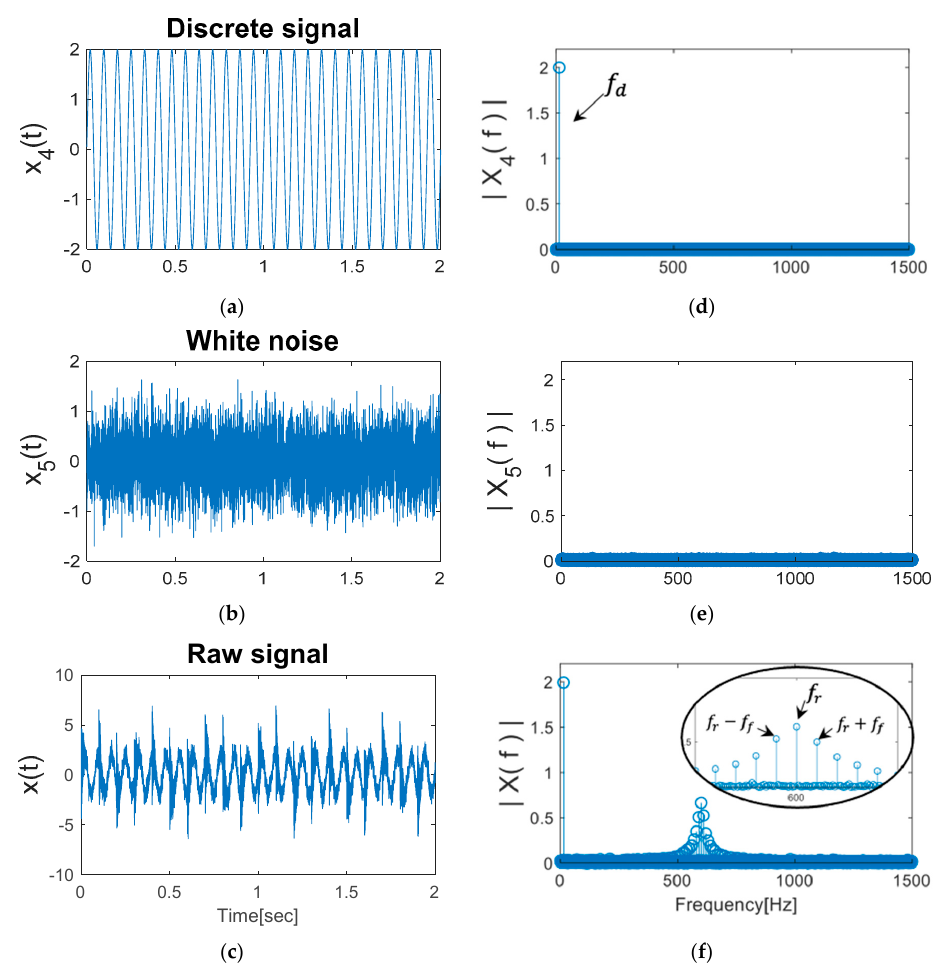
Figure 4. Simulation of bearing fault signal: ( a ) discrete signal, ( b ) white noise, ( c ) raw signal, in the time domain; ( d ) discrete signal, ( e ) white noise, ( f ) raw signal, in the frequency domain.